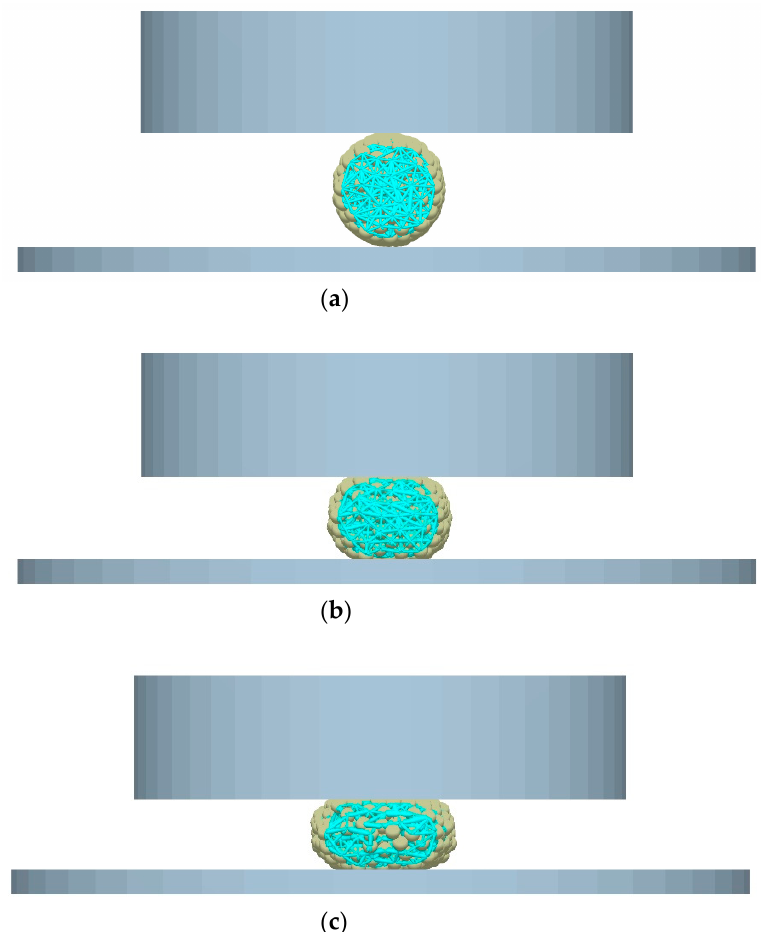
Figure 7. The simulation process of extrusion rupture. ( a ) Compression 0 mm; ( b ) compression 1.23 × 10 − 3 m; and ( c ) compression 1.74 × 10 − 3 m.